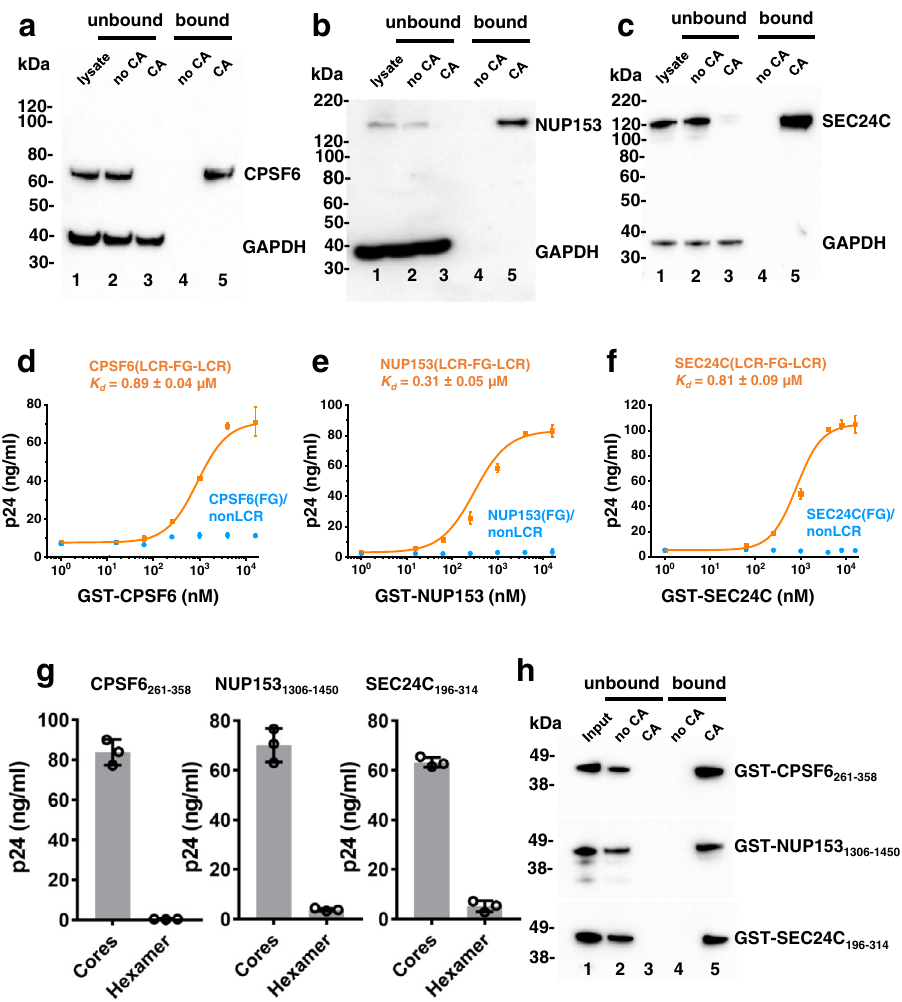
Fig.1|BiochemicalcharacterizationofCPSF6,NUP153andSEC24Cinteractions with HIV-1 cores and CA tubes. Representative immunoblots showing CA nanotube mediated co-pelleting of endogenous CPSF6 ( a ), NUP153 ( b ) and SEC24C ( c ) from MT4 cell lysates. The proteins of interest were visualized by antibodies ab175237(Abcam) against CPSF6, NB100-93329 (Novus) against NUP153, ab122633 (Abcam) against SEC24C. Lane 1: cell lysate. Lane 2: supernatant or unbound fraction after pelleting in the absence of CA tubes. Lane 3: supernatant or unbound fraction after co-pelleting with pre-formed CA tubes. Lane 4: pelleted or bound fraction in the absence of CA tubes. Lane 5: pelleted or bound fraction in the presence of CA tubes. The experiments were repeated 3 times independently with similar results. Quantitation of GST-mediated af fi nity pull-down of native HIV-1 cores bound to indicated concentrations of GST-CPSF6 261-358 (LCR-FG-LCR) vs GST-CPSF6(FG)/nonLCR ( d ), GST-NUP153 1306-1450 (LCR-FG-LCR) vs GST-NUP153(FG)/nonLCR ( e ); and